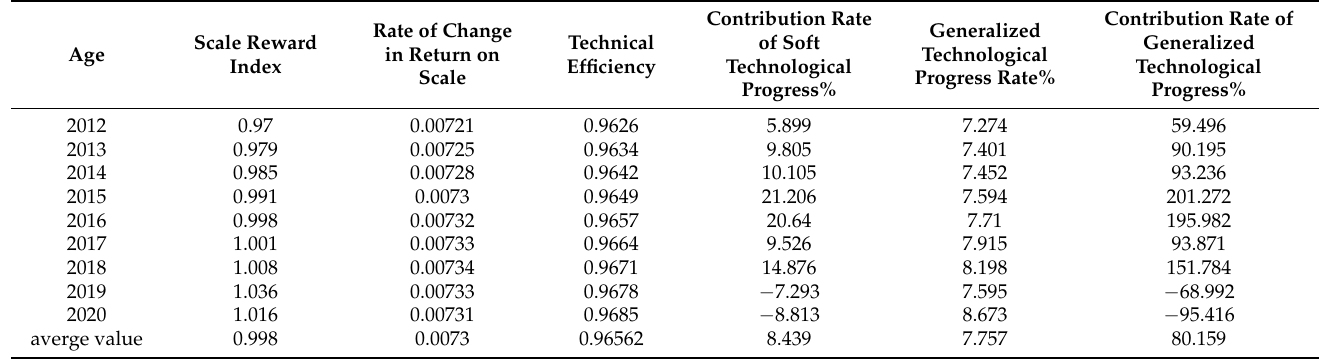
Table 4. General technological progress rate and contribution rate of fisheries in China from 2012 to